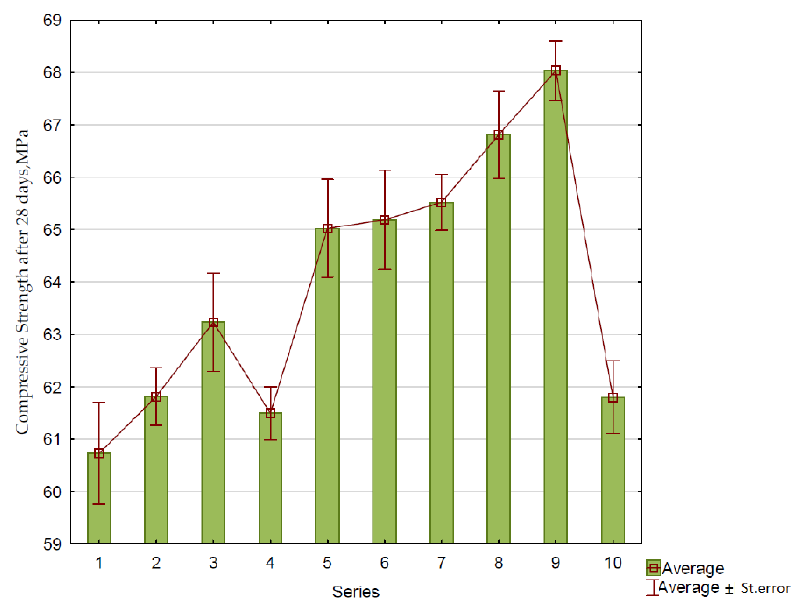
Figure 6. Average results of the compressive strength (MPa) test after 28 days of maturation in comparison with the control series (No. 10).